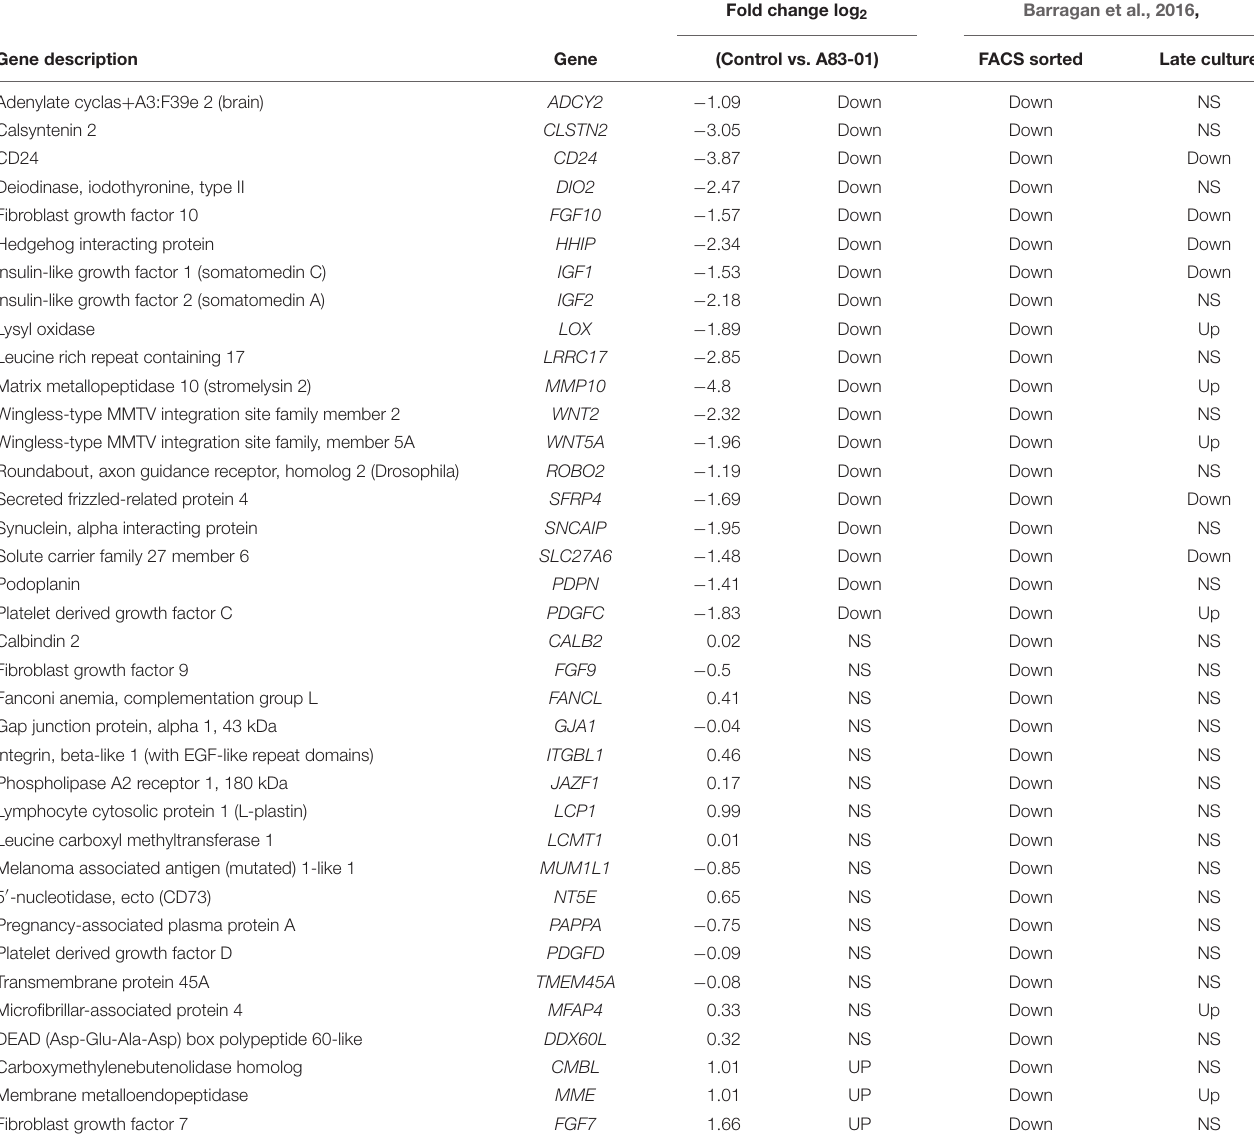
Fold change log